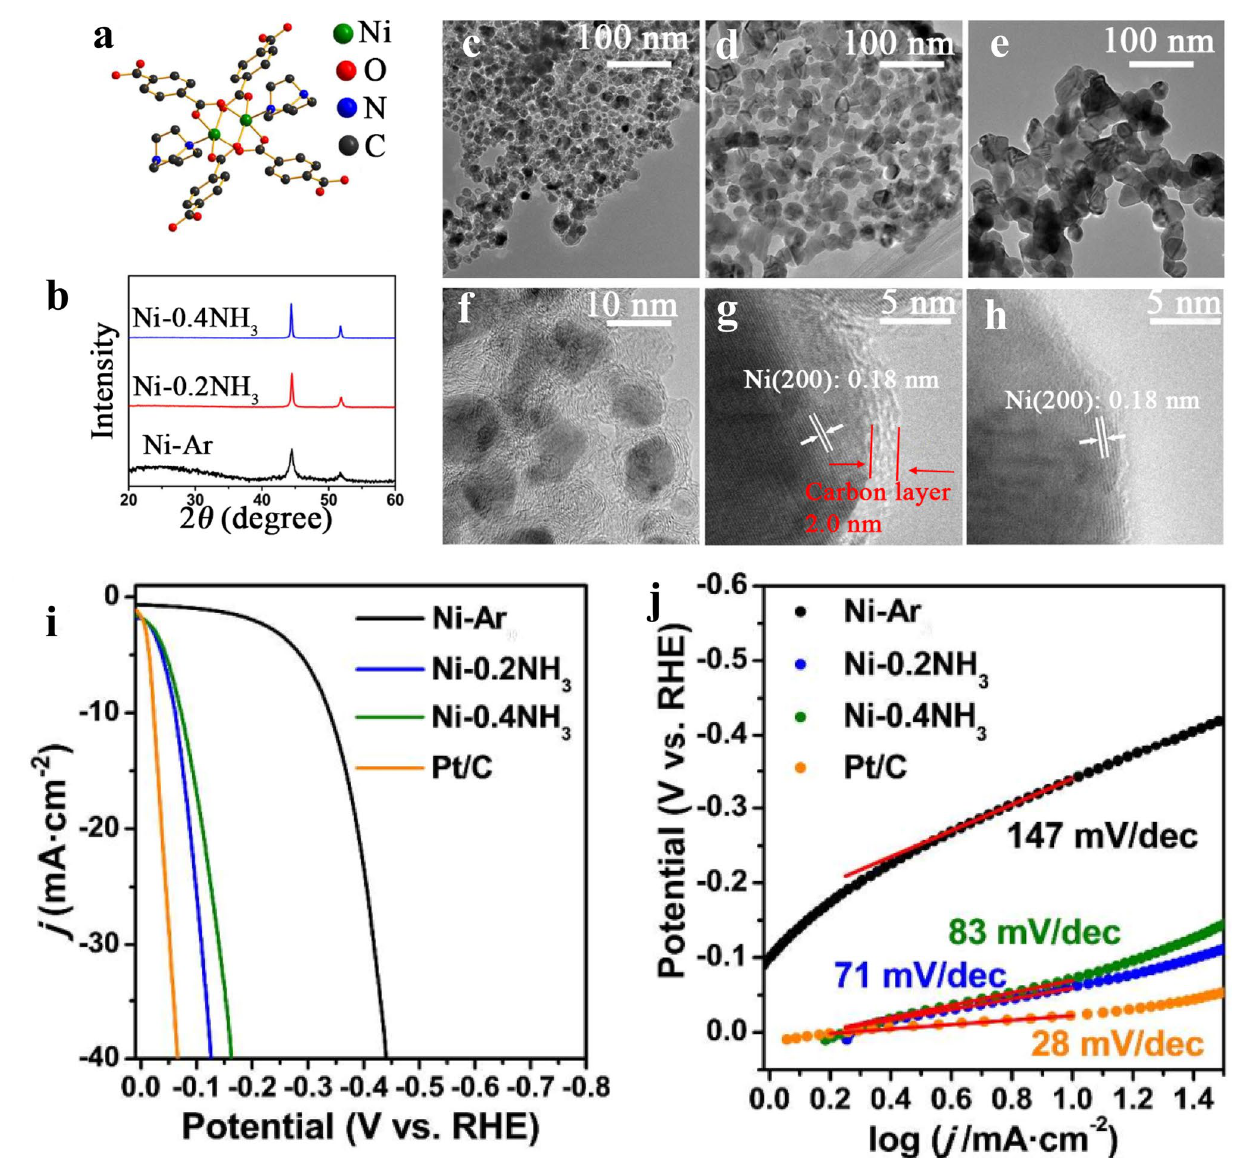
Fig. 10 a Structure of the Ni coordination environment in Ni 2 (bdc) 2 (ted), b XRD patterns of the Ni-MOF-derived catalysts, c–h TEM images of the Ni-MOF-derived catalysts, i linear scanning voltammograms, and j Tafel plots of the MOF-derived catalysts in 1 M KOH solution